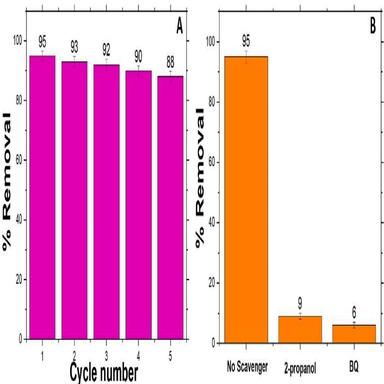
(A) 5-cycle reuse of Co-BDC, 0.05 mM H2O2 in the degradation of MB (5 ppm) and (B) quenching experiment of the active species during catalytic degradation of MB (5 ppm) over Co-BDC CP, 0.05 mM H2O2, with the addition of BQ and 2-propanol as scavengers for • OH and HO2 • respectively.